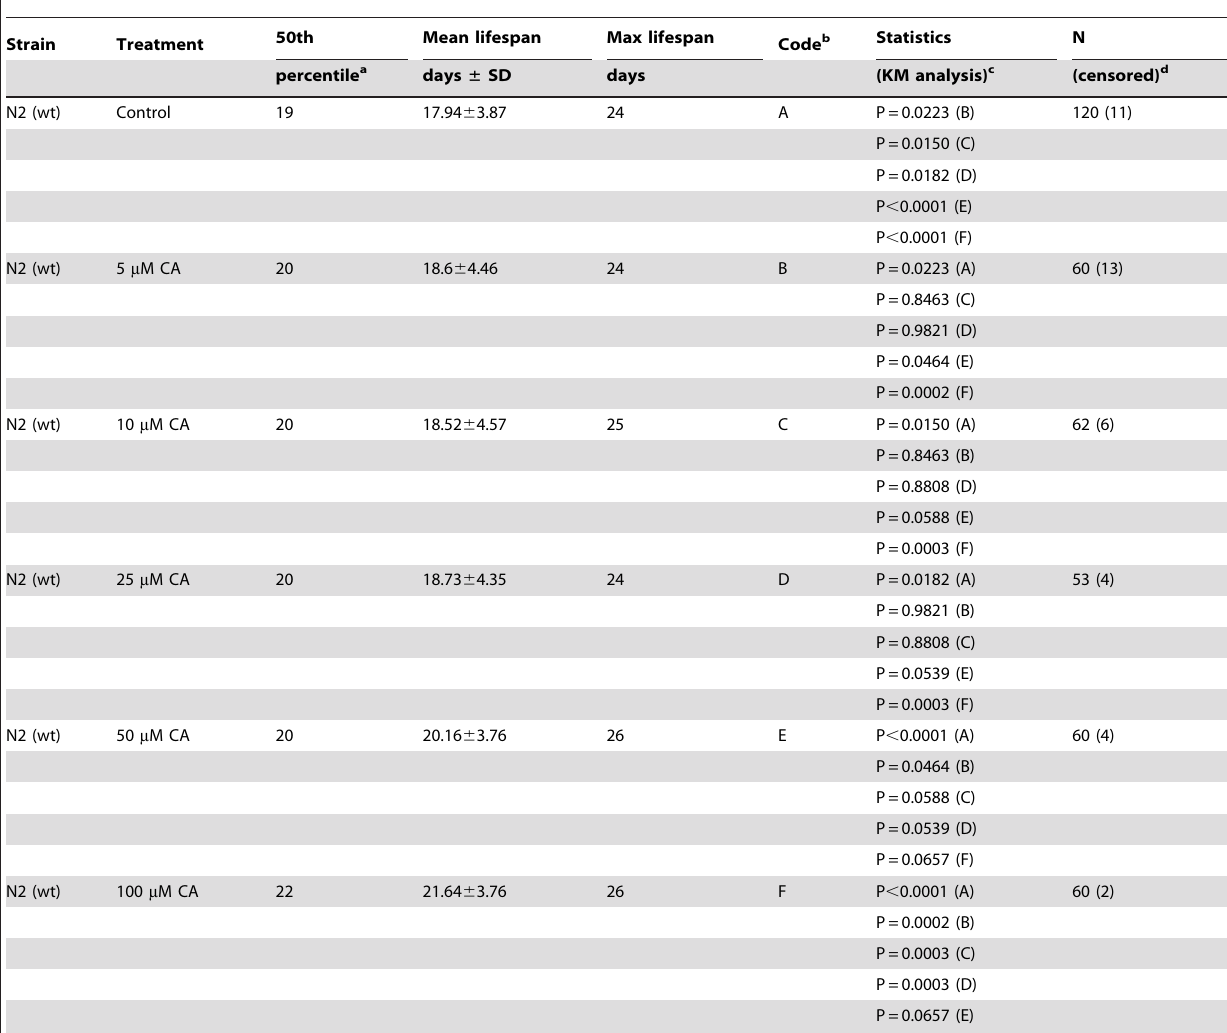
Table 1. Chicoric acid-dependent lifespan modulation of C. elegans